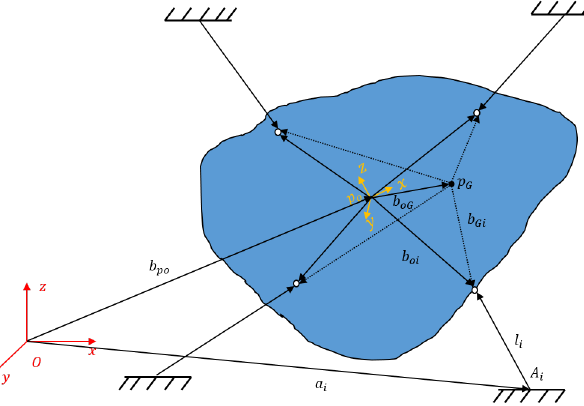
Figure 1. Model of cable-driven parallel